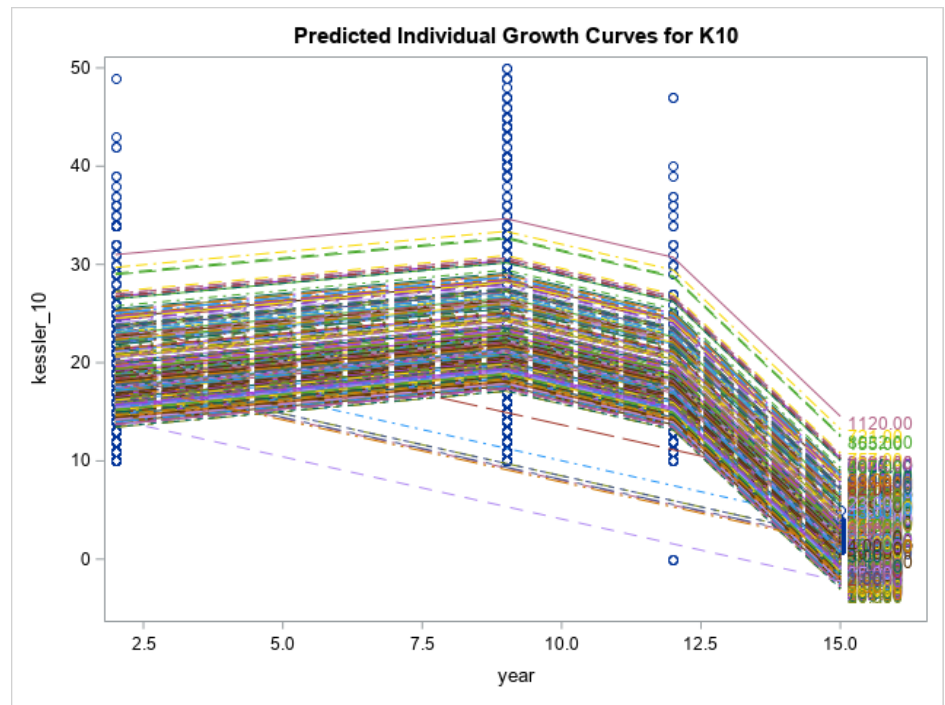
Figure 4. Predicted individual growth curves for eating restraint. The blue lines indicate the measurement time points.